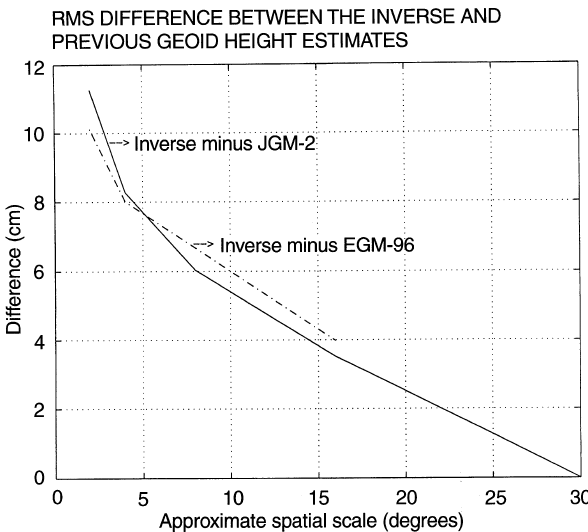
Fig. 11. Root mean square di(cid:128)erence as a function of scale between the inverse model geoid height estimate and: the JGM-2 estimate ( solid line ); the EGM-96 estimate ( dot-dashed